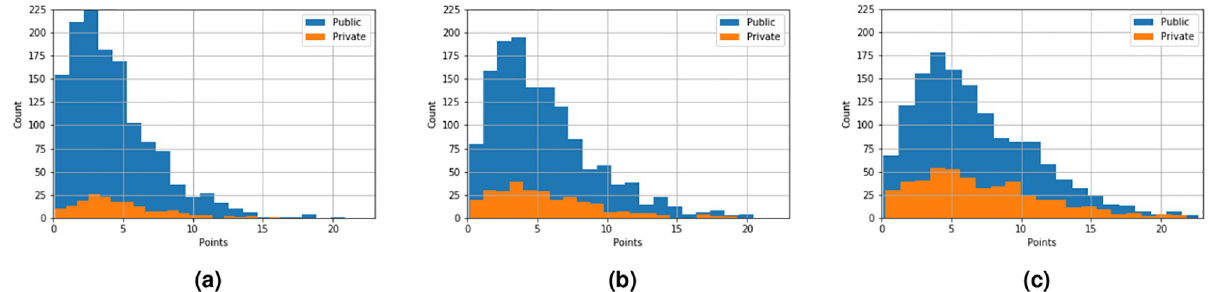
Fig 7. Histograms of PISA points divided in three quantiles (low-high in (a)-(c)) of public school ESCS in Sweden show that public schools have a large part of their students in the lowest quantile (a), while the opposite is true for private schools (c). This can explain part of the higher PISA results and grades in private schools in